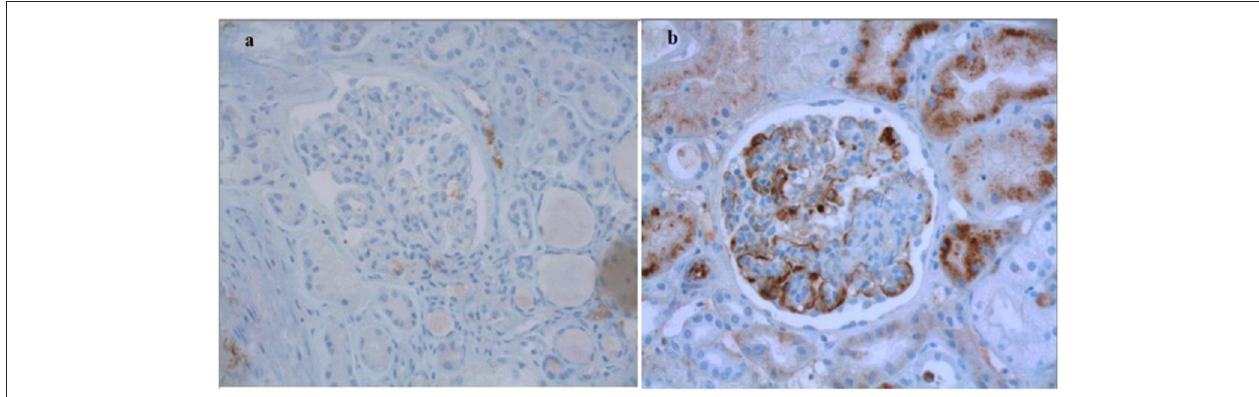
FIGURE 2 | Representative views of C4d immunohistochemistry on kidney biospies of patients with IgAV. (a) Absence of staining. (b) Positive parietal staining. Original magnification x400.